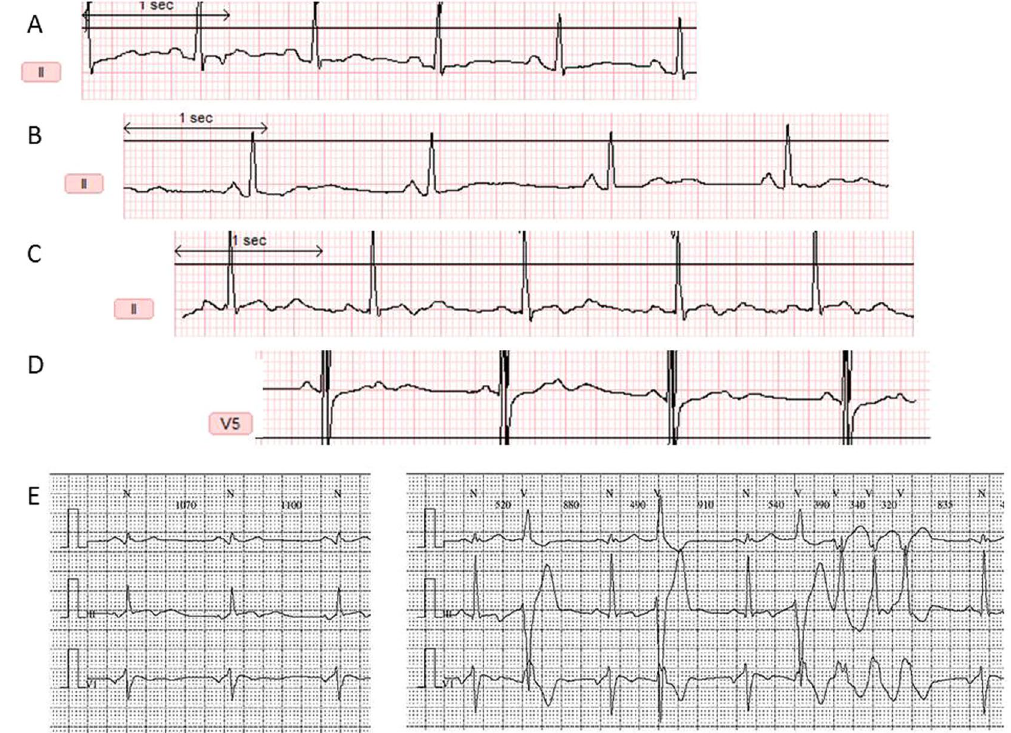
Figure 2. Sinusoidal T-U waves morphology in 4 additional patients with TGF β R2 mutations. ( A ) 32 year- old women, p.Arg537Cys mutation, QTcB = 466 ms, LVEF 73%, LVEDD 41 mm, normal mitral valve. ( B ) 42 year-old women, p.Q511X mutation, QTcB = 435 ms, LVEF 70%, LVEDD 50 mm, mitral valve prolapse. ( C ) 15 year-old boy, p.Asp524Asn mutation, QTcB = 381 ms, normal LVEF, LVEDD 58 mm, mitral valve prolapse. ( D ) 27 year-old woman, p.Asn384Asp mutation, QTcB = 425 ms, normal LVEF, LVEDD 53 mm, normal mitral valve. ( E ) Holter ECG of a 15 year-old boy carrying the p.Asp524Asn mutation. Upper part: abnormal T-U wave morphology with prominent U wave. Lower part: right bundle branch block morphology ventricular run. ECG signal of Fig. 2A–D have been digitized for better quality